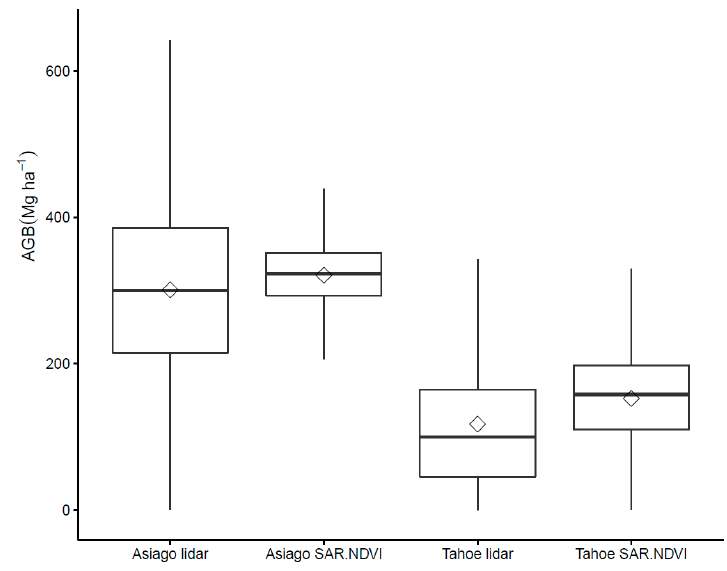
Figure 5. SAR + NDVI based map for Tahoe area ( left ) and Asiago area ( right ).